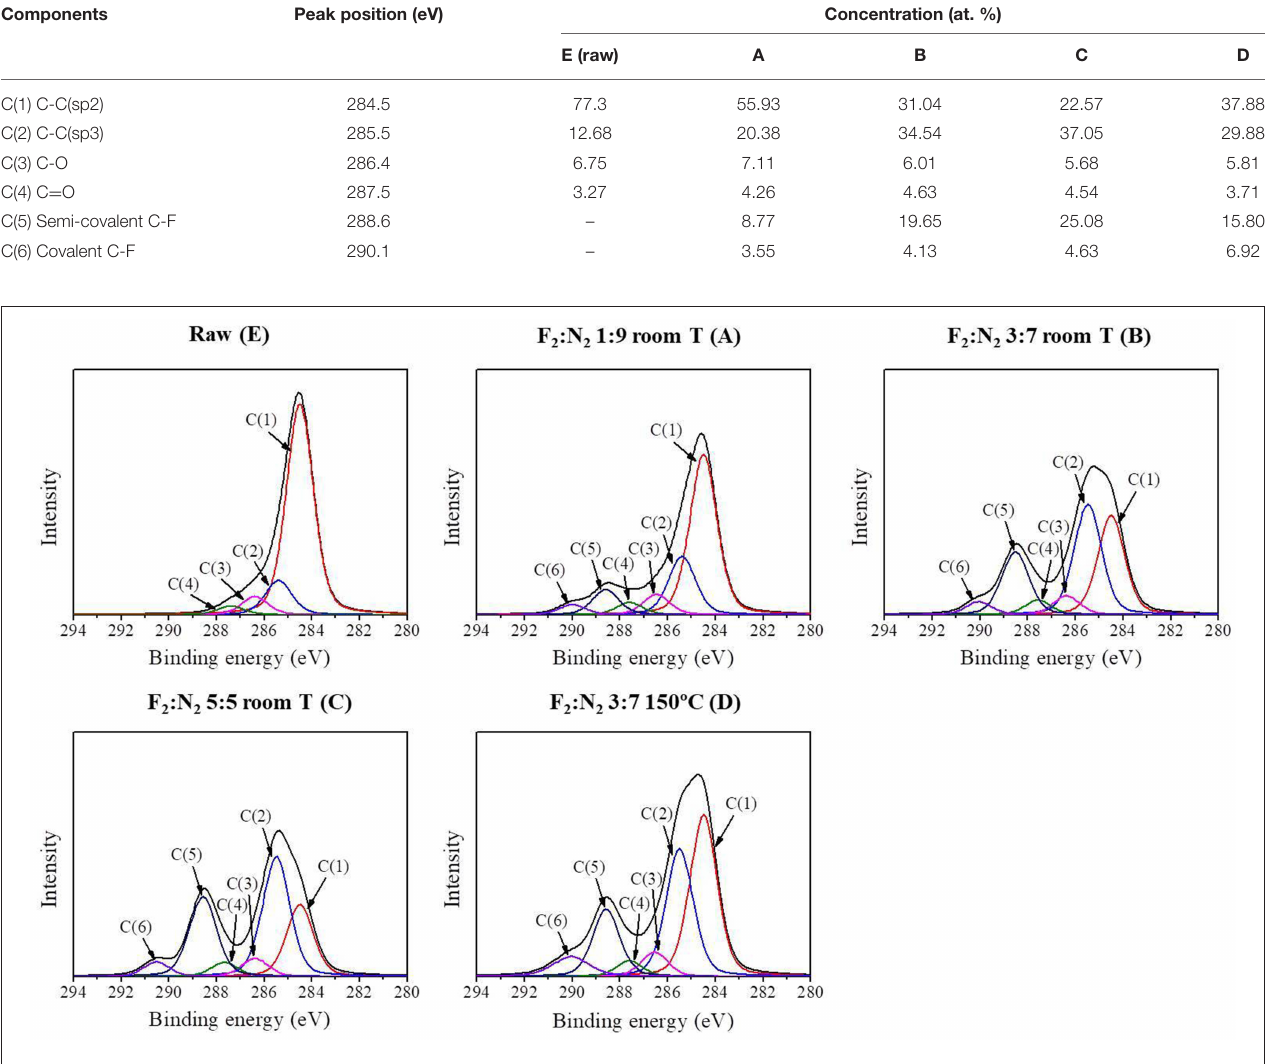
FIGURE 1 | Deconvolution of the XPS C1s spectra of the